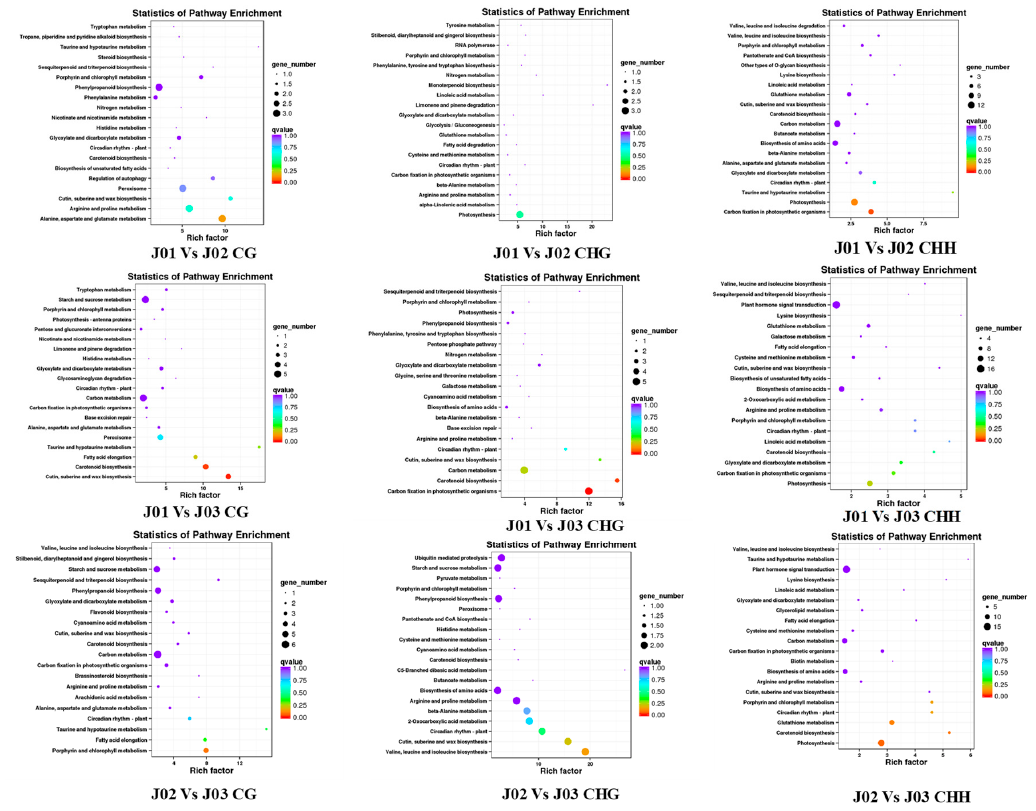
Figure 7. The KEGG pathway analysis of the DMRs in the different methylation types and different comparative groups. For the three methylation types (CG, CHG, and CHH) in the methylated genes of the CK_vs_Sense and CK_vs_Antisense groups, the pathway mainly focused on oxidative phosphorylation, starch and sucrose metabolism, and plant hormone signal transduction. In contrast, the methylated genes of the Sense_vs_Antisense groups of the CHG methylation type were different and mainly included the pentose phosphate pathway, limonene and pinene degradation, and protein export.